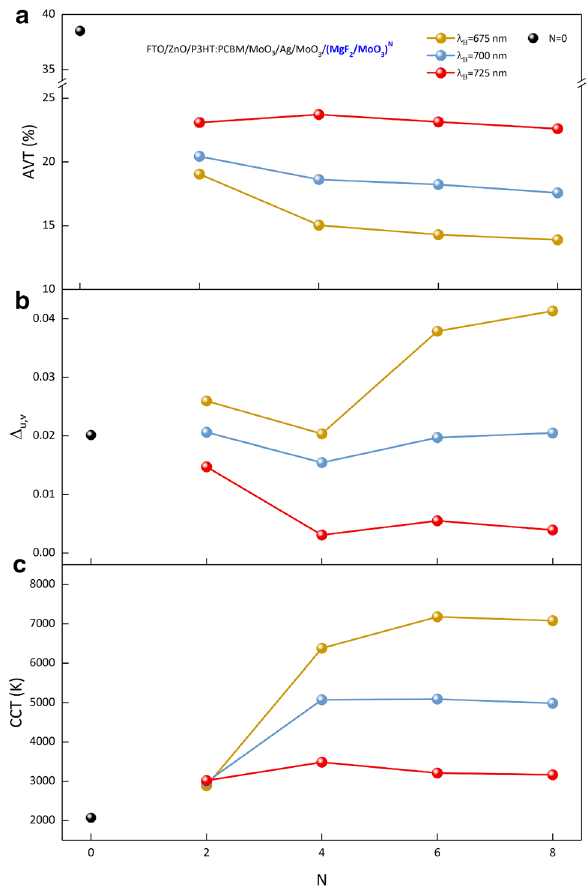
Figure 4. Optical parameters of the semi-transparent organic solar cell. For ST-OSC/(MgF 2 /MoO 3 ) N , ( a ) AVT, ( b ) Δ u,v and ( c ) CCT changes according to the number of periods at different λ B . The black spherical symbol denotes the optical parameters of ST-OSC.